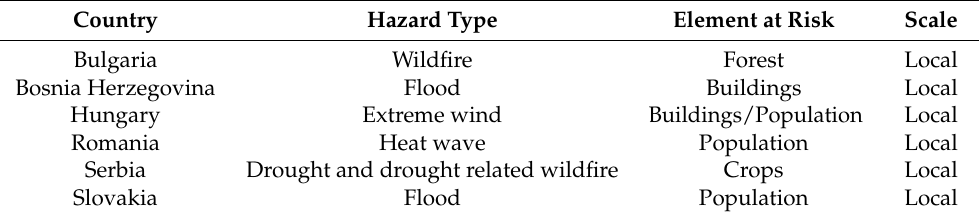
Table 1. Case studies for the application of the CRAM [46]. Country Hazard Type Element at Risk